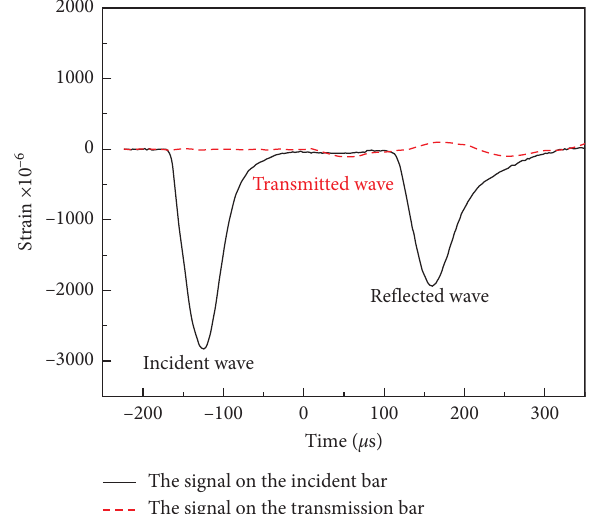
Figure 9: Results of the PMMA-steel bar impact test.